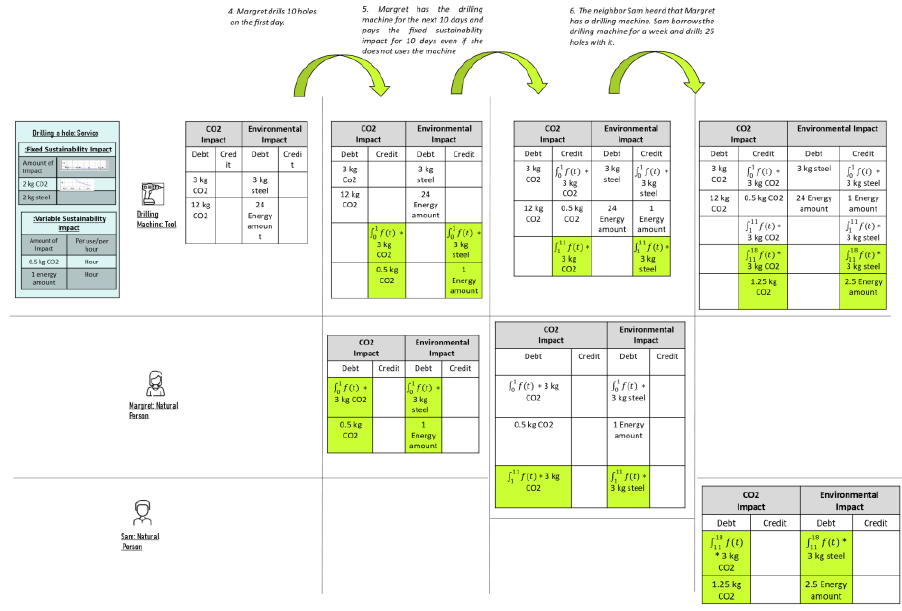
Figure 3. Tracing of the Sustainability Impact Factor and the meta-model example. Calculation of the Balance of Sustainability varies based on whether it is a Variable or Fixed Sustainability